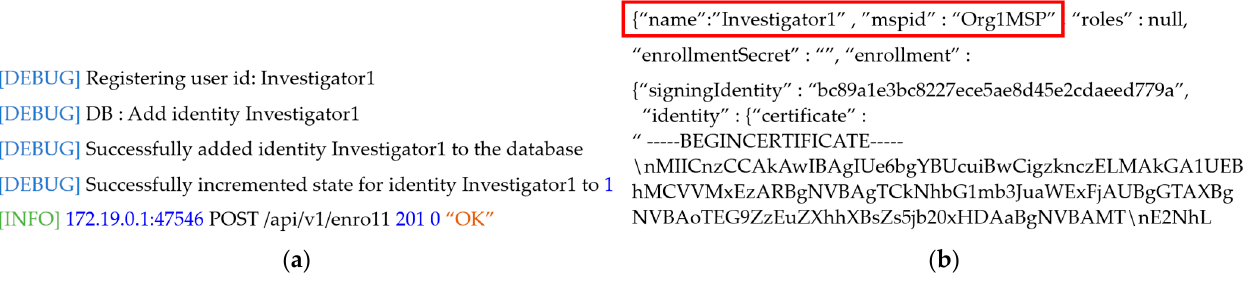
Figure 4. Identity registration by ( a ) institution, and ( b ) digital authentication issuance of the two-level blockchain system.